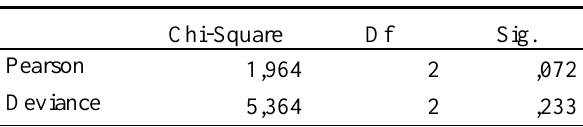
Table 5. Model Goodness of Fit Test Results